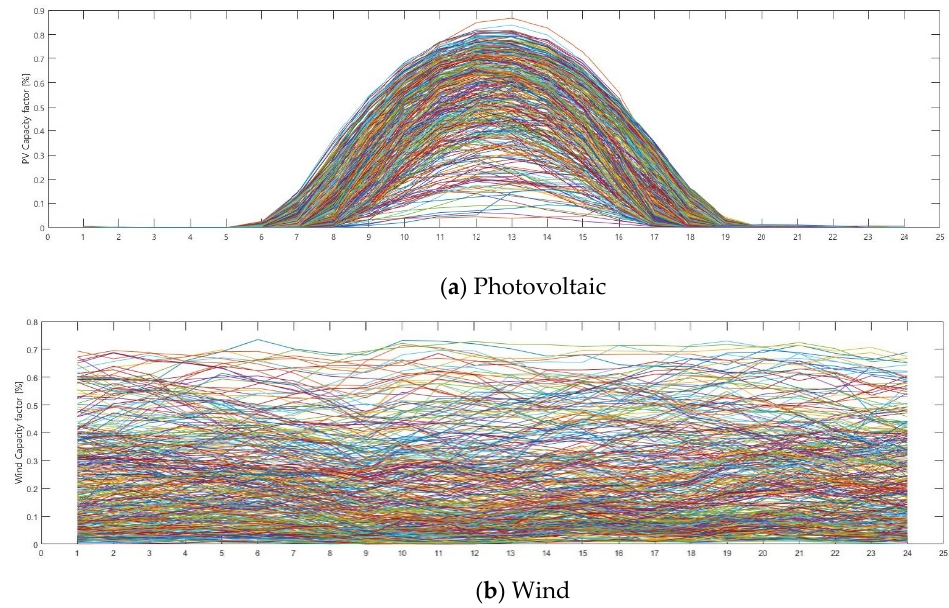
Figure 3. A historical hourly capacity factor of 2019: ( a ) PV; ( b ) Wind.